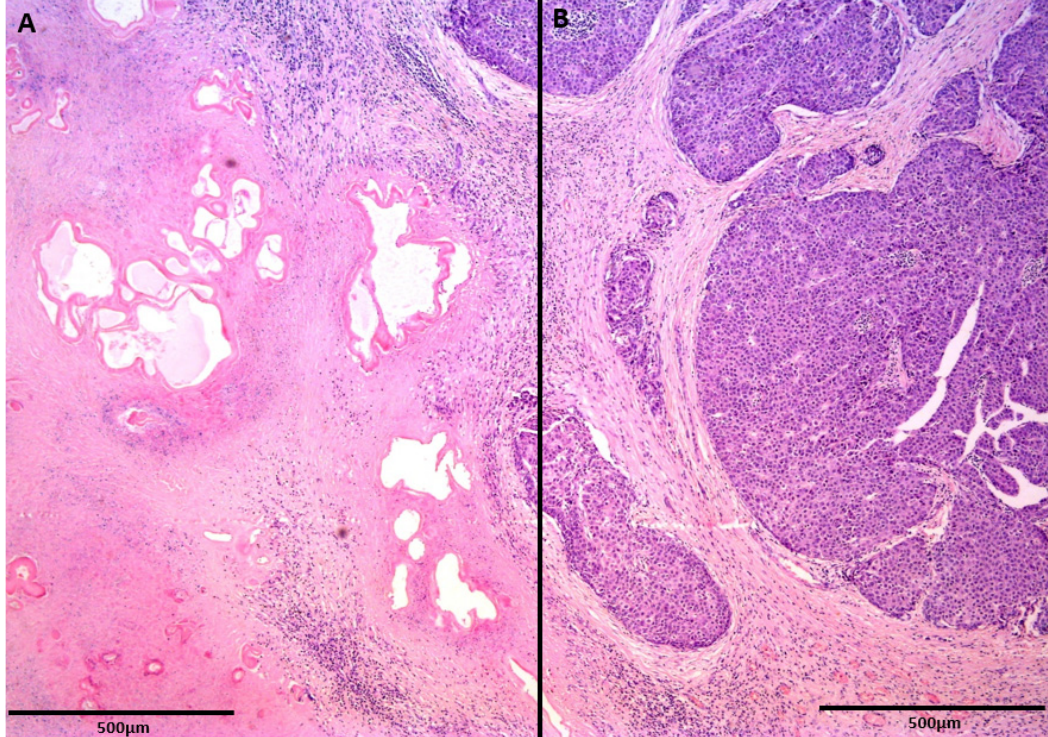
Figure 5. A histological examination clearly depicts the collision of two lesions: parasitic cysts sur- rounded by a fibrohistiocytic rim ( A ) and peripheral nodular and trabecular proliferation of hepa- tocellular carcinoma ( B ). Scale bar = 500 µm.